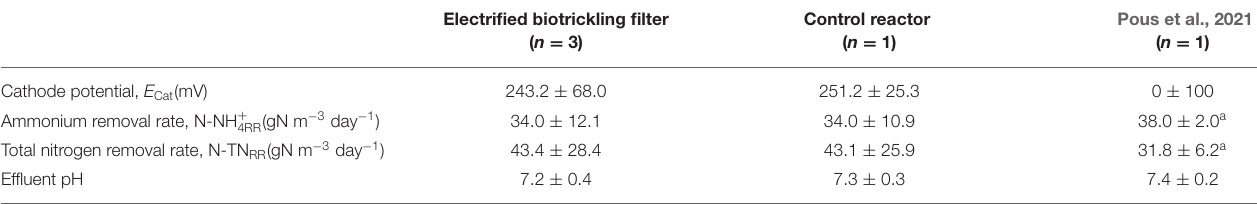
Pous et al., 2021 ( n = 1)